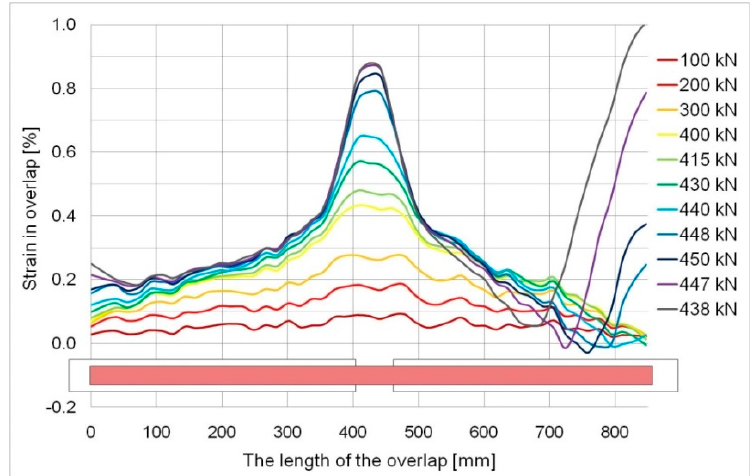
Figure 13. The strains determined over the whole overlap length, specimen S/DL/MA/RS-400-4/P2.